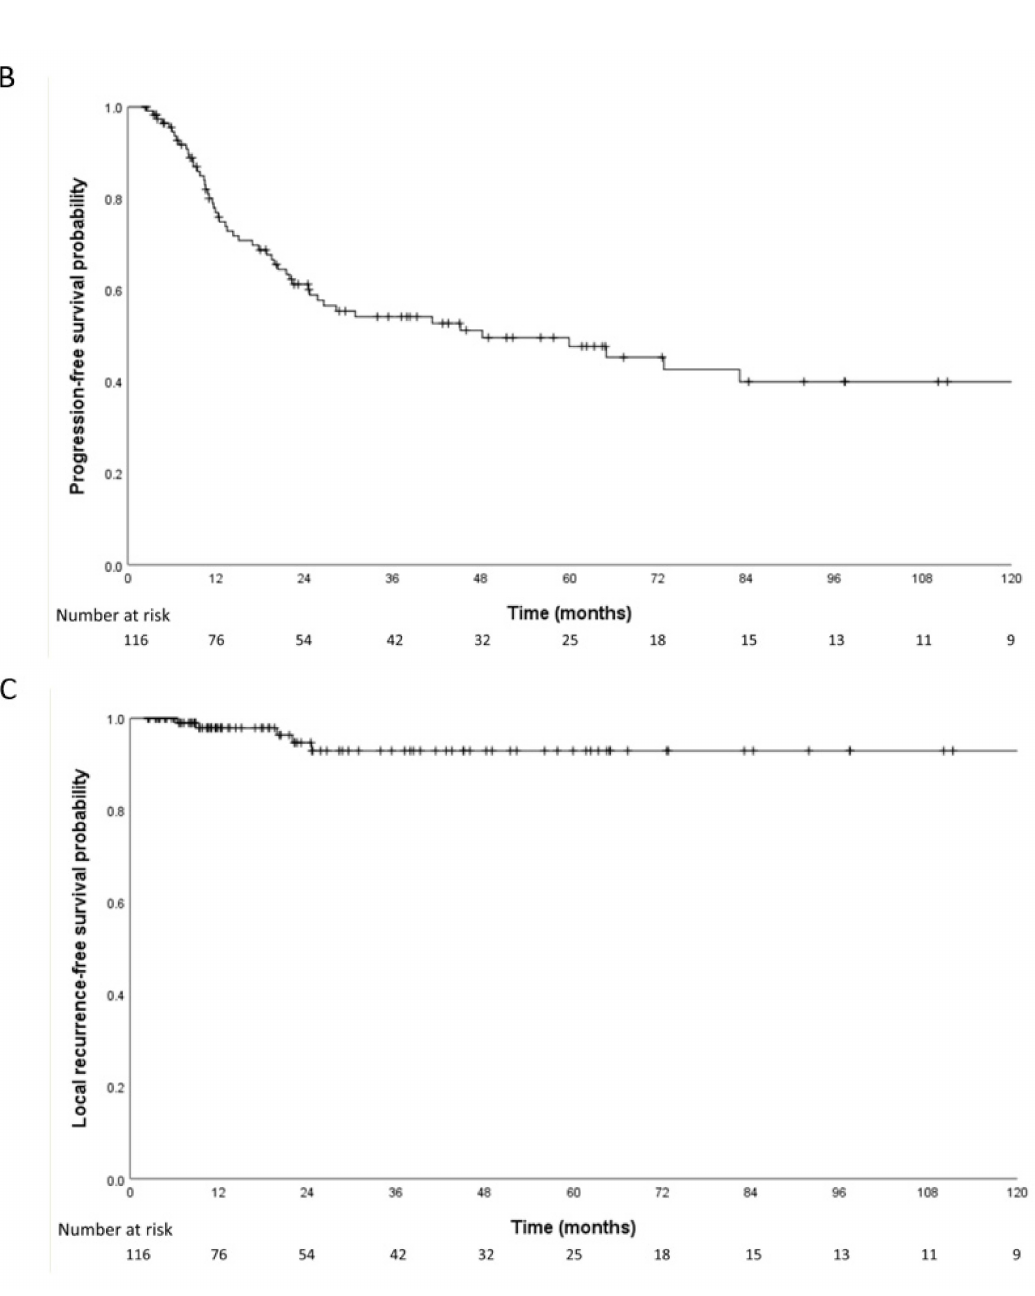
Figure 1. Kaplan–Meier survival curves for overall survival ( A ), progression-free survival ( B ), and local recurrence-free survival ( C